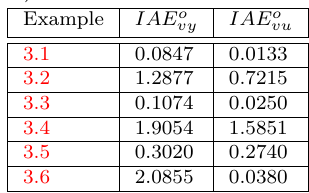
Figure 10: Example 3.6: Performance vs. robustness vs. input usage, J vs. M t vs. M ks trade-off surface. Comparing Alg. 2.1, IMC-PIDF vs. the PO-PID controllers for the process model at row 6, col. 2 in Table 3. The servo-regulator, s r = 0 . 5, and the weights for the PO criterion in Eq. (13) are given in Table 5. Table 4: Examples and the corresponding reference controllers, i.e. the optimal input and out- put performances for prescribed M st = 1 . 59